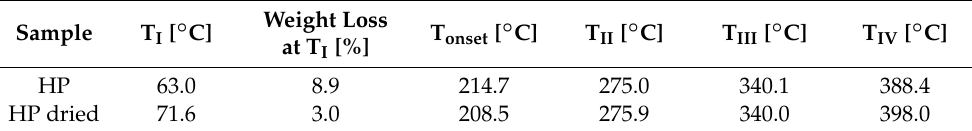
Figure 5. Thermogravimetric curves of not dried (HP) and dried (HP dried) hazelnut perisperm samples. Table 4. Degradation onset temperatures (T onset ) and DTGmax temperatures at which the degradation speed is maximum for not dried (HP) and dried (HP dried) hazelnut perisperm samples.